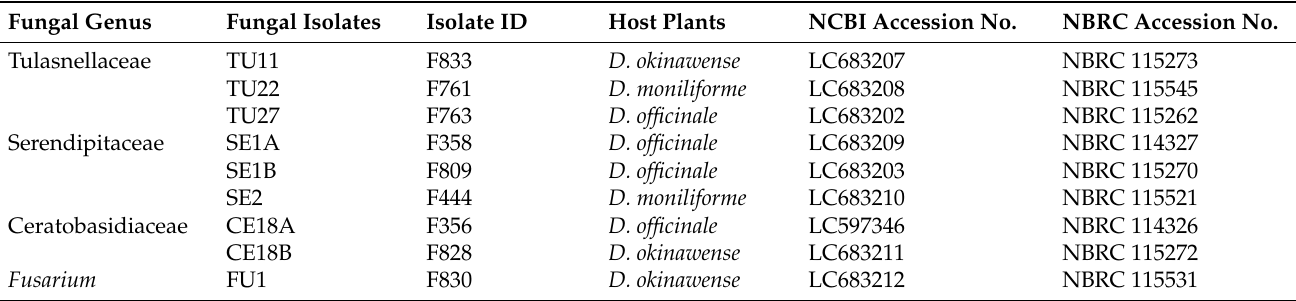
Table 1. Fungal isolates from Dendrobium officinale, D. okinawense , and D. moniliforme used for symbiotic